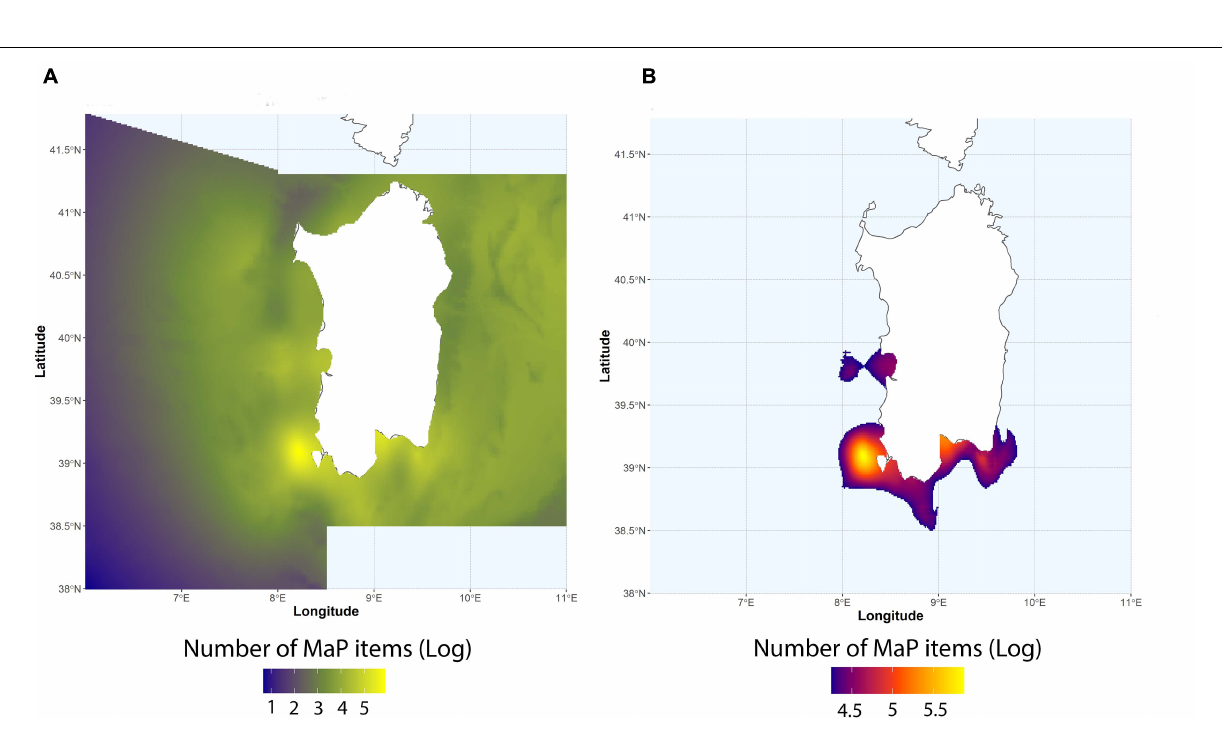
FIGURE 4 | (A) Interpolated log-values of number of plastic items via IDW. (B) Computed hotspots of plastic accumulation according to the 90th